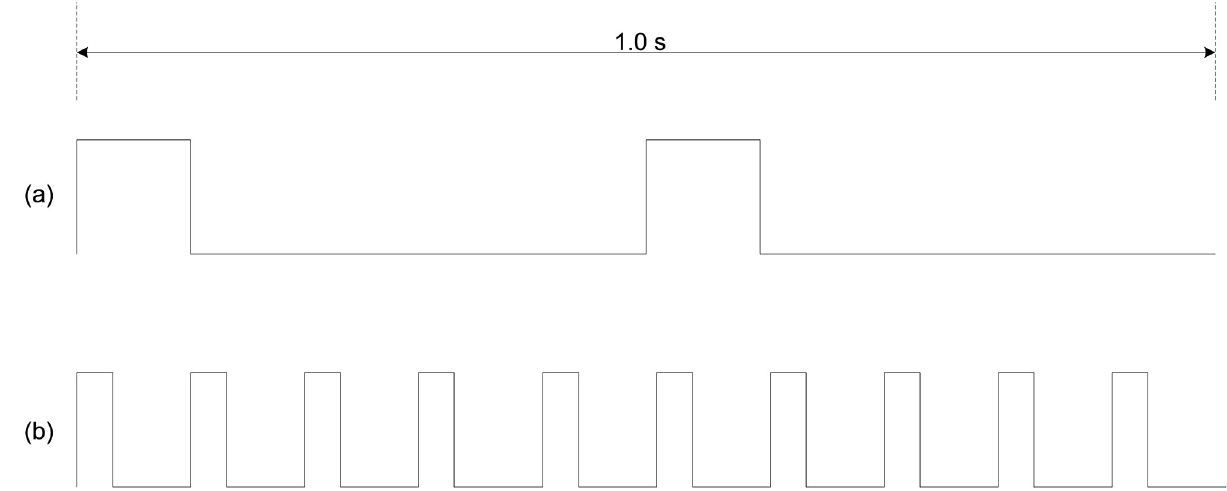
Fig 2. PDC frequencies (a: 2 Hz; b: 10 Hz) used to investigate juvenile eel response to electric fields in flowing